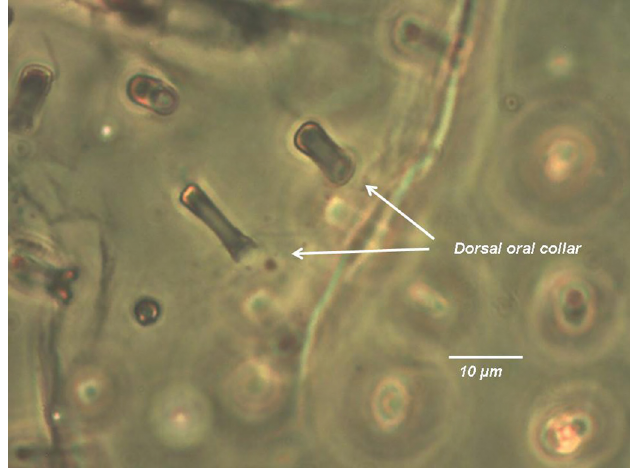
Figure 5. Nipaecoccus coffeae : two sizes of dorsal oral collars.